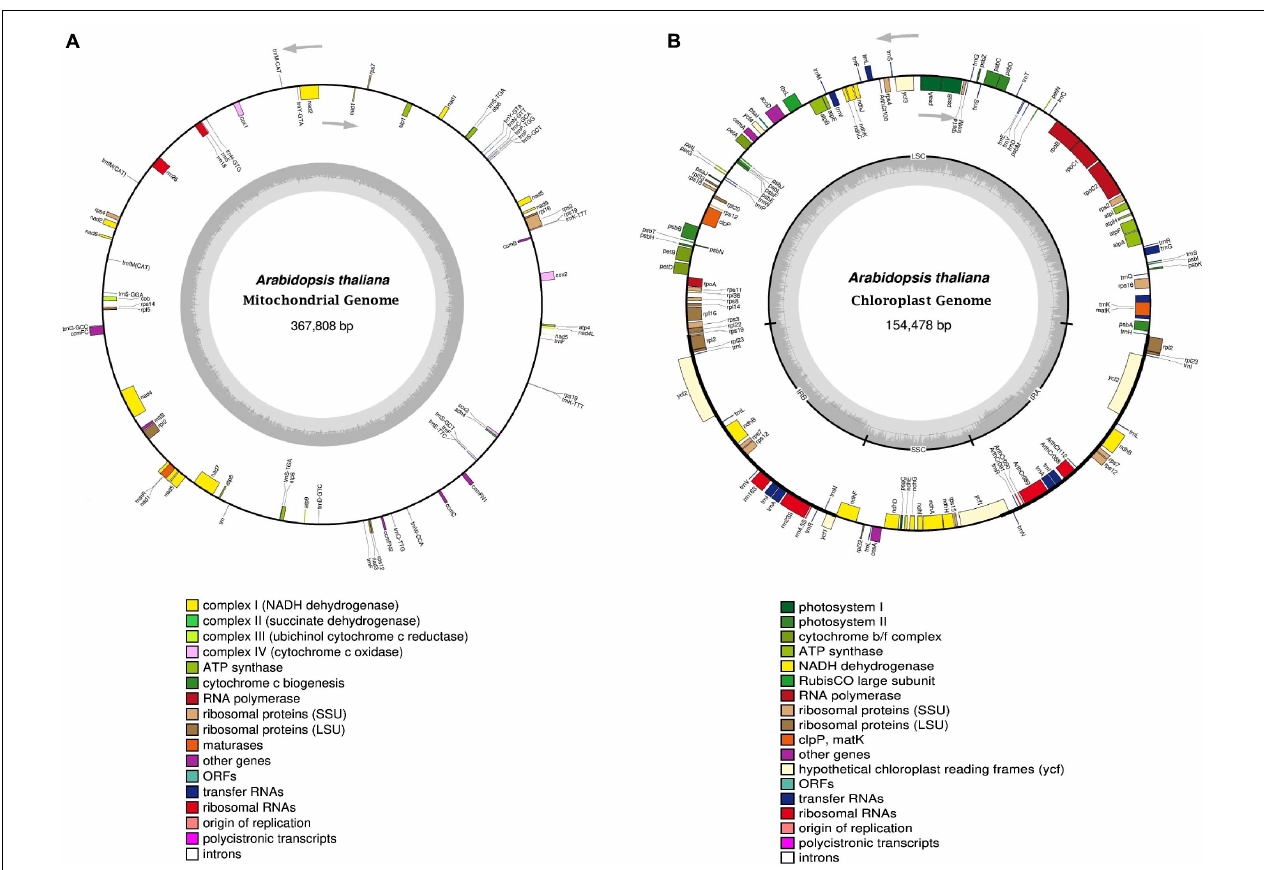
FIGURE 1 | Structural organization of organelle genomes in Arabidopsis thaliana . (A) and (B) Circular gene map of mitochondrial and chloroplast genome, respectively. The gray arrowheads indicate the direction of genes. Genes shown inside and outside the outer circle are transcribed clockwise and anticlockwise respectively. Genes belonging to different groups are color coded. The genome coordinate and GC content are shown in the inner circle. The darker gray region corresponds to GC content, whereas the lighter gray region corresponds to AT content. In the chloroplast genome, the thick lines indicate inverted repeats (IRA and IRB), which separate the genome into small (SSC) and large (LSC) single copy regions. Genome diagrams are adapted from the output of OGDRAW (Greiner et al.,